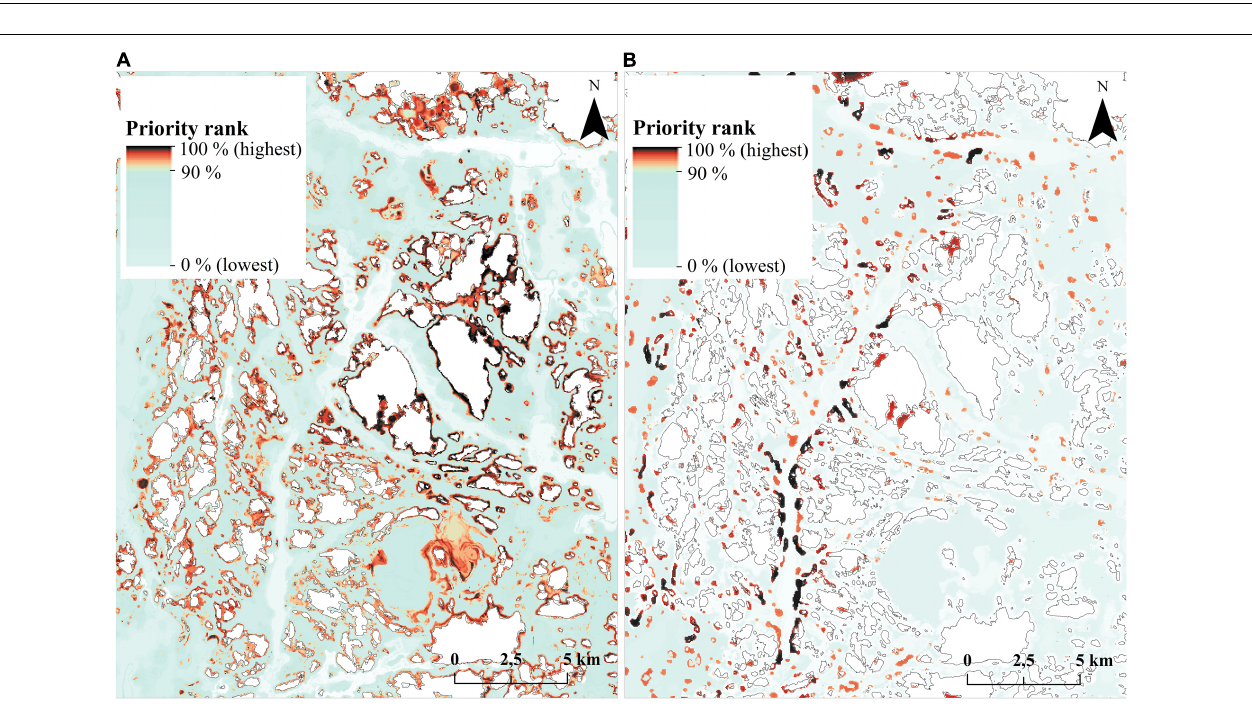
FIGURE 9 | Surrogacy of species and marine habitats. (A) Performance curves for analysis driven by species data only and (B) performance curves for analysis driven by habitat data alone.